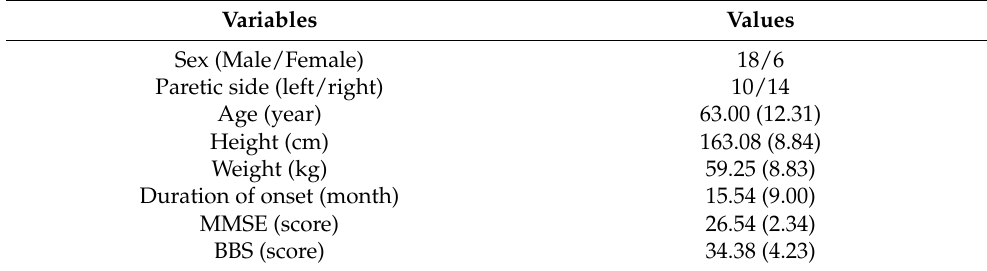
Table 1. The general characteristics of